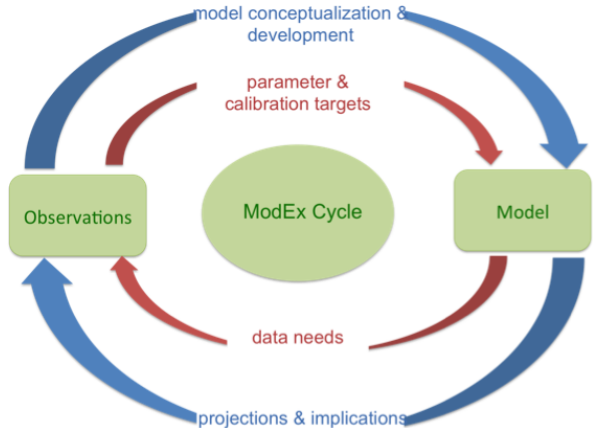
Figure 2. Schematic representation of a Model Observa- tion/Experiment (ModEx) process involving traditional param- eter estimation–calibration (inner loop) and model structural– conceptual refinement (outer loop). Observations inform simulation input and provide a starting point for a conceptual model. Both the conceptual and numerical model is then tested against obser- vations. In successive ModEx iterations the model is then refined and at times re-drawn in order to elicit governing processes that shape model outcome to match observed and measured phenom- ena. Finally, model experiments and the identification of governing processes inform future observations as to which measurements are needed to assess the state of the